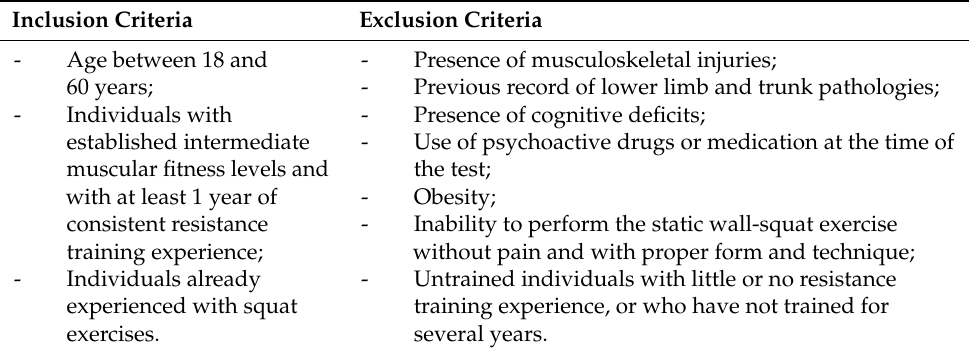
Table 1. Inclusion and exclusion